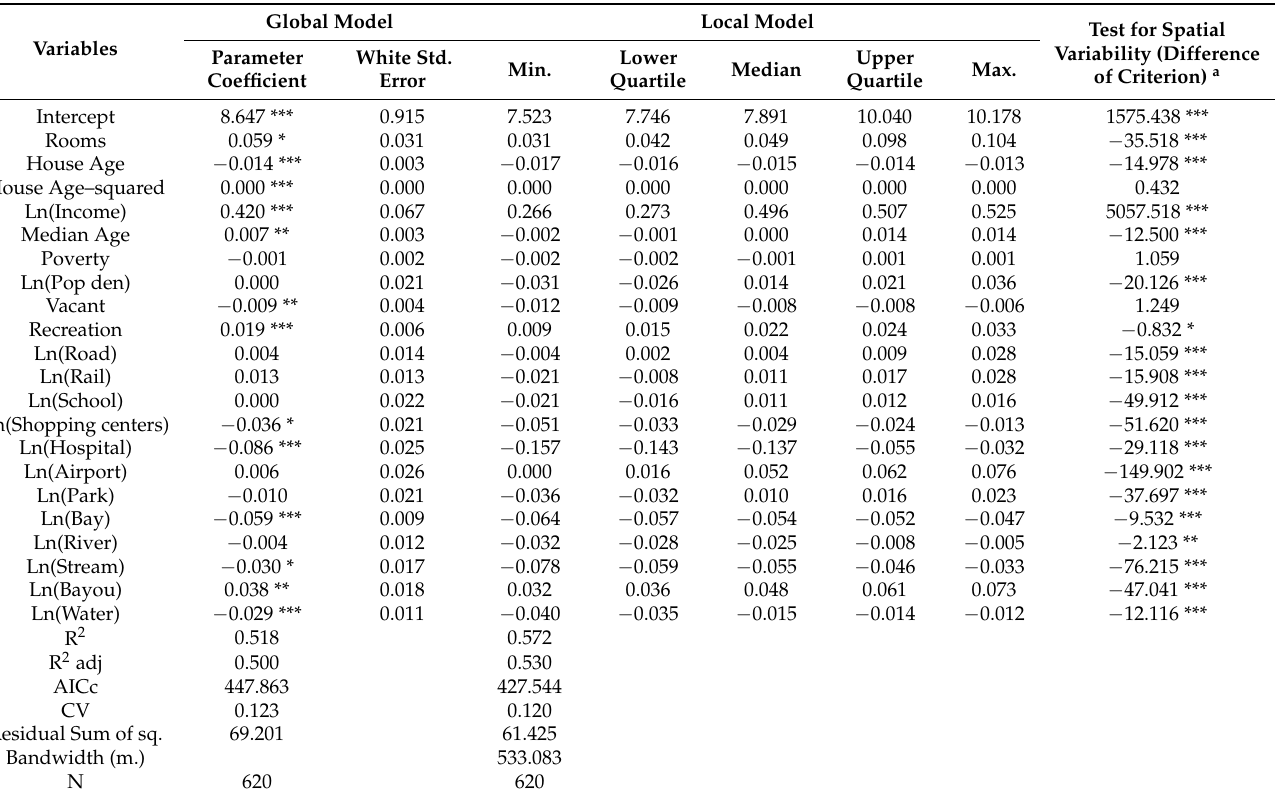
Table 2. Parameter estimates from the ordinary least square (OLS) global and geographically weighted regression (GWR) local models used to estimate the monetary value associated with proximity to waterfront ecosystem services in Mississippi and Alabama (U.S.), and results of the spatial variability